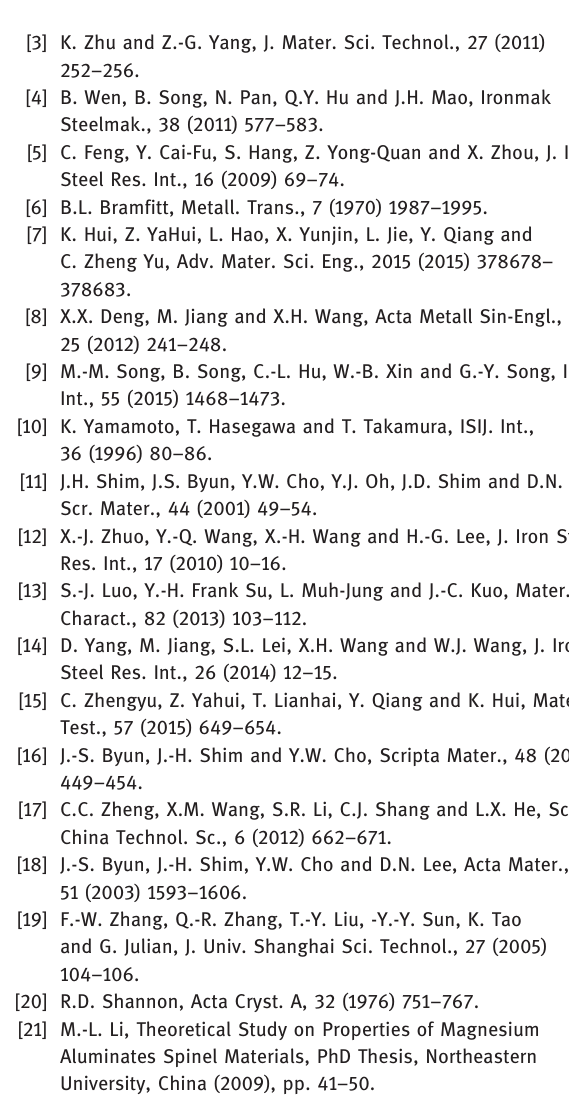
Figure 5: The SEM micrograph, EDS mapping images and EDS Line analysis of Mn for pure MnS in Mg-treated sample after